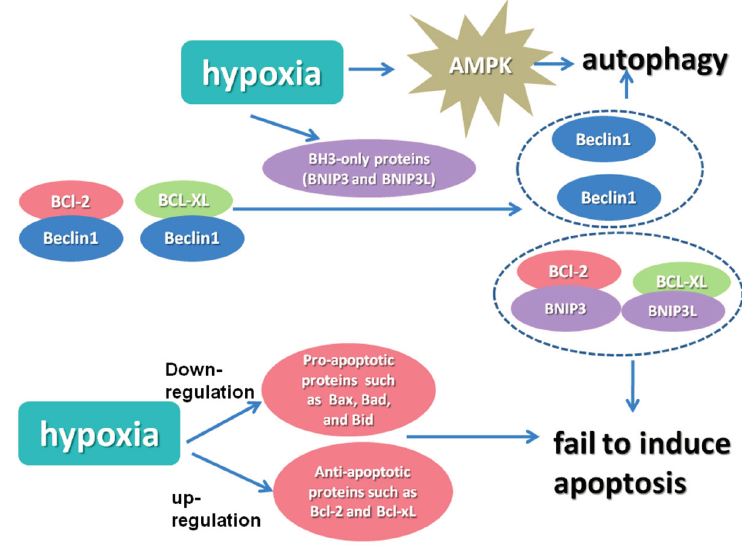
Figure 1. Mechanisms of hypoxia-induced autophagy and apoptosis resistance. In